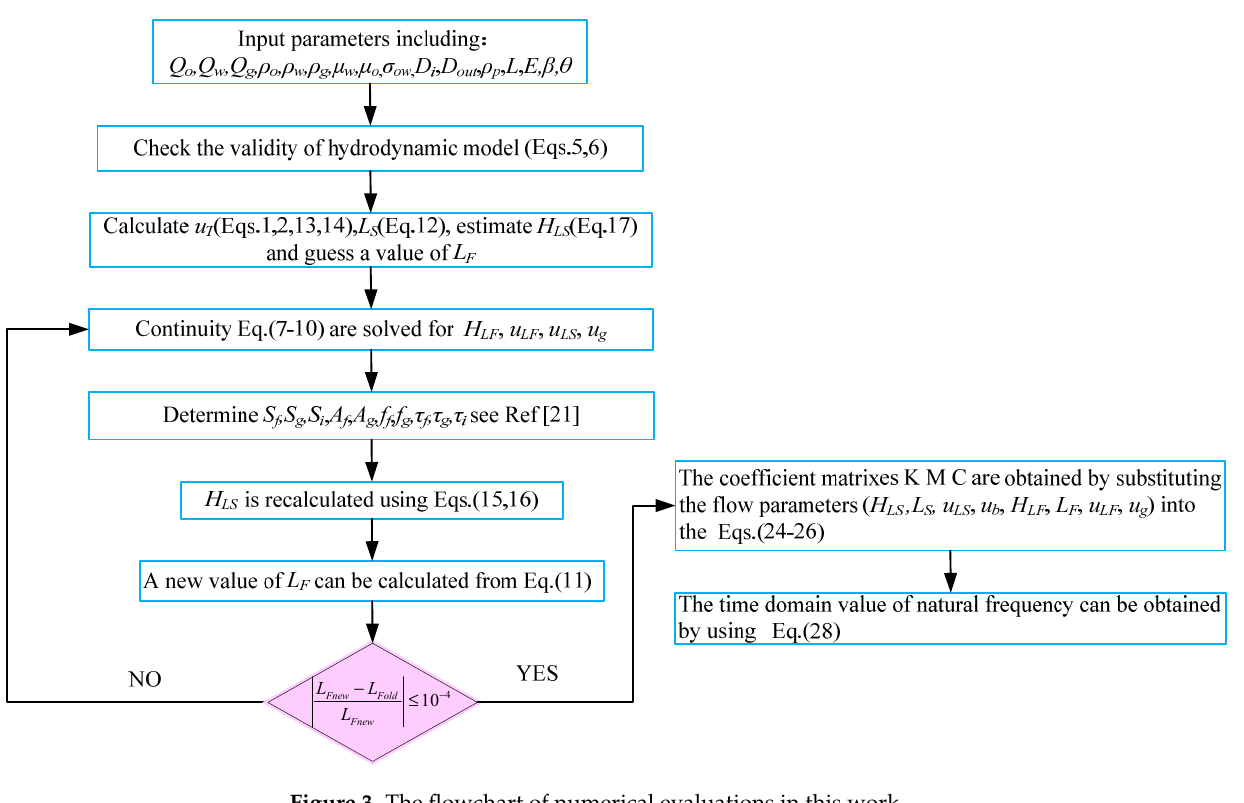
Figure 3. The flowchart of numerical evaluations in this work.